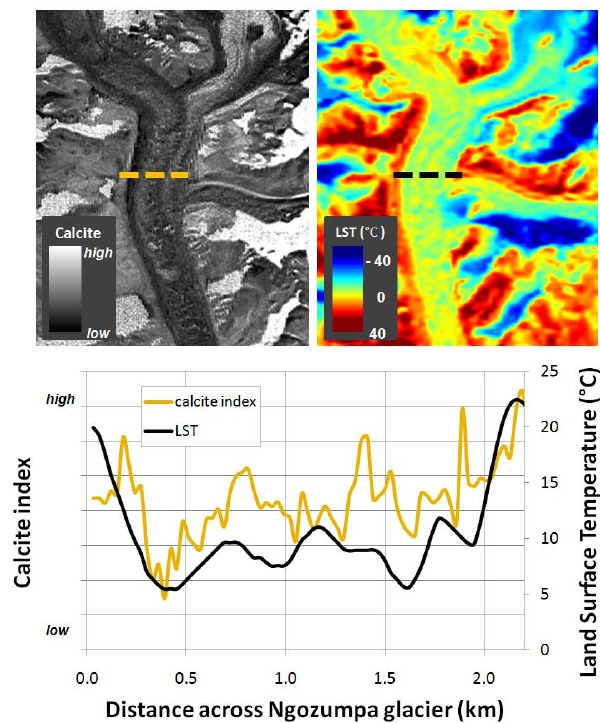
Fig. 8. Khumbu glacier ASTER L1B calcite abundance (top left) is compared with Landsat TM derived surface temperature (top right). The plot beneath displays calcite abundance and surface tempera- ture variation down glacier. In situ surface temperature measure- ments are indicated on the top right map by the purple “X” anno- tations. Glacier surface temperature increases approximately 15 ◦ C two kilometers down glacier from the Khumbu icefall and increases further toward the